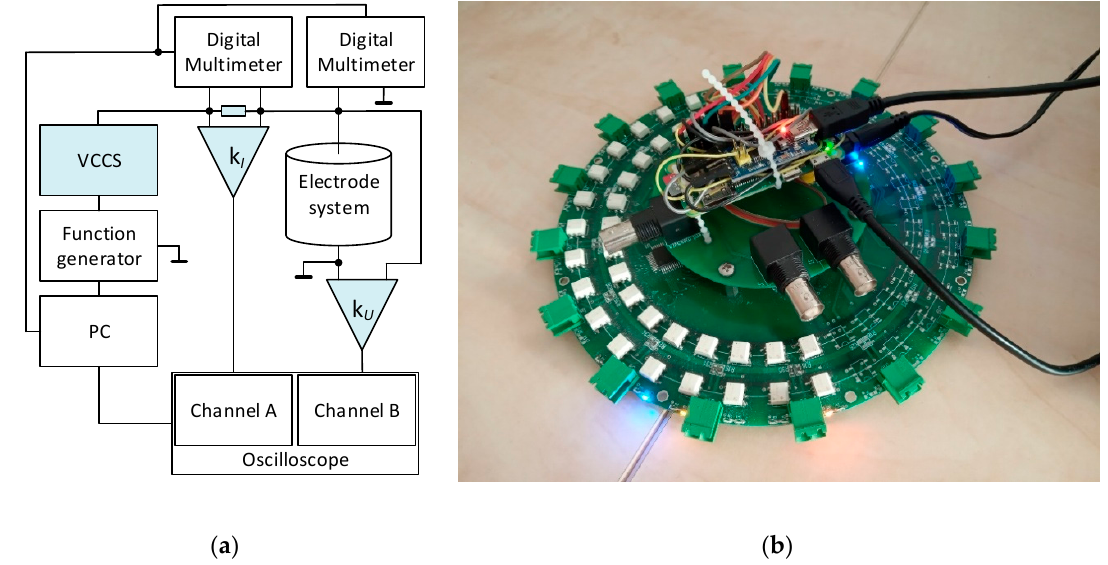
Figure 2. ( a ) The diagram describing the acquisition of the voltage and phase shift data to allow the conductivity recon- struction; ( b ) the prototype of the PLI EIT system (first version).